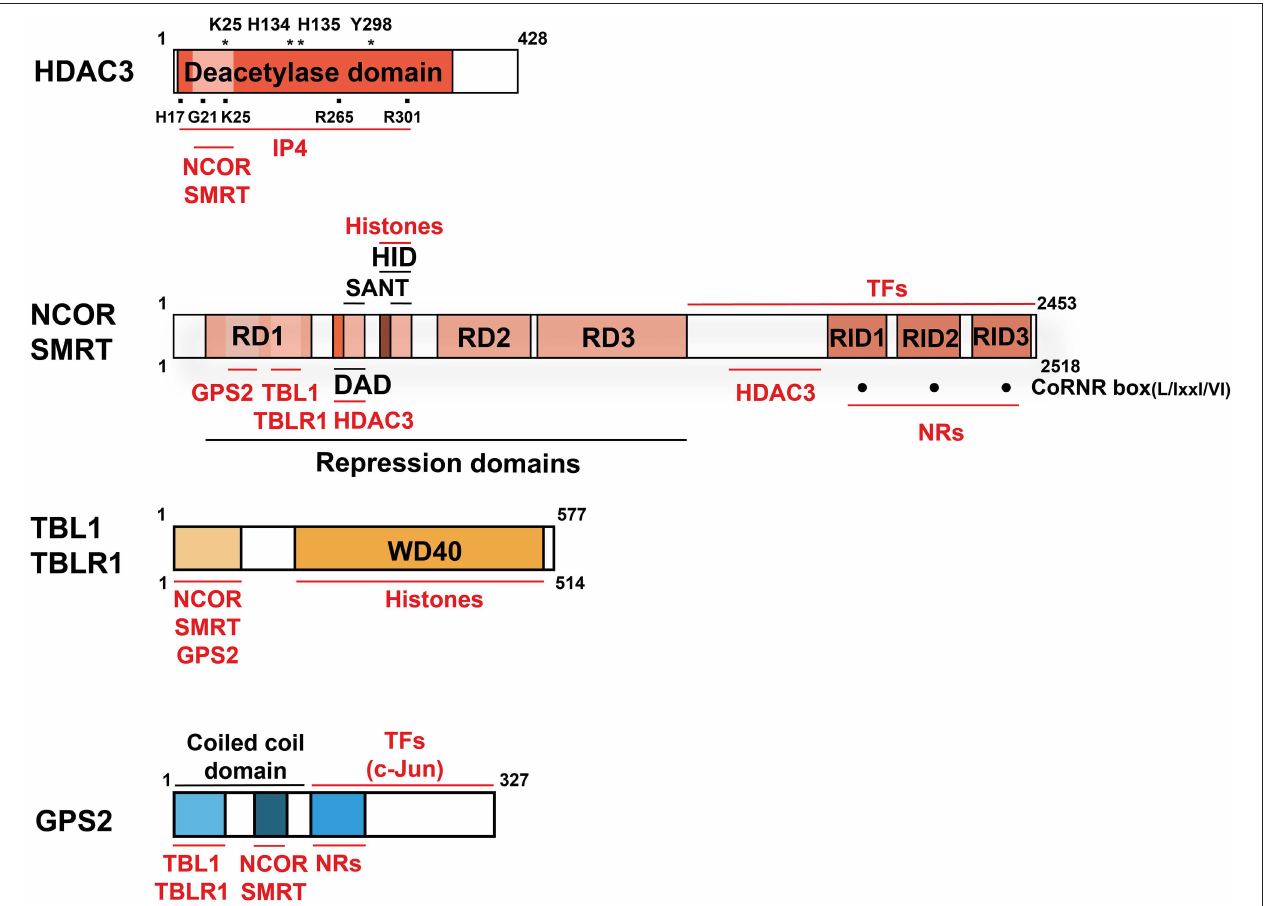
FIGURE 2 | Domain structure and interactions of the co-repressor complex core subunits. Structural domains are labeled in BLACK and interacting proteins and molecules are labeled in RED. Indicated is the size (aa) of the human proteins (wild-type, full-length cDNAs of major isoforms). For HDAC3, mutations of several aa, marked with (*), abolish deacetylase activity. The aa marked with ( (cid:4) ) are involved in the HDAC3-IP4 interaction. For NCOR and SMRT, three C-terminal CoRNR-boxes ( · ) mediate NR-interactions and thus serve as RIDs. Note that the numbering of the RIDs in NCOR and SMRT differs in individual publications and no consensus nomenclature exists. NCOR, SMRT, and GPS2 interact directly also with other TFs than NRs, but the interaction domains are poorly characterized. NCOR/SMRT and TBL/TBLR1 interact additionally with hypoacetylated histones, thereby stabilizing chromatin interactions of the entire complex. Key abbreviations: